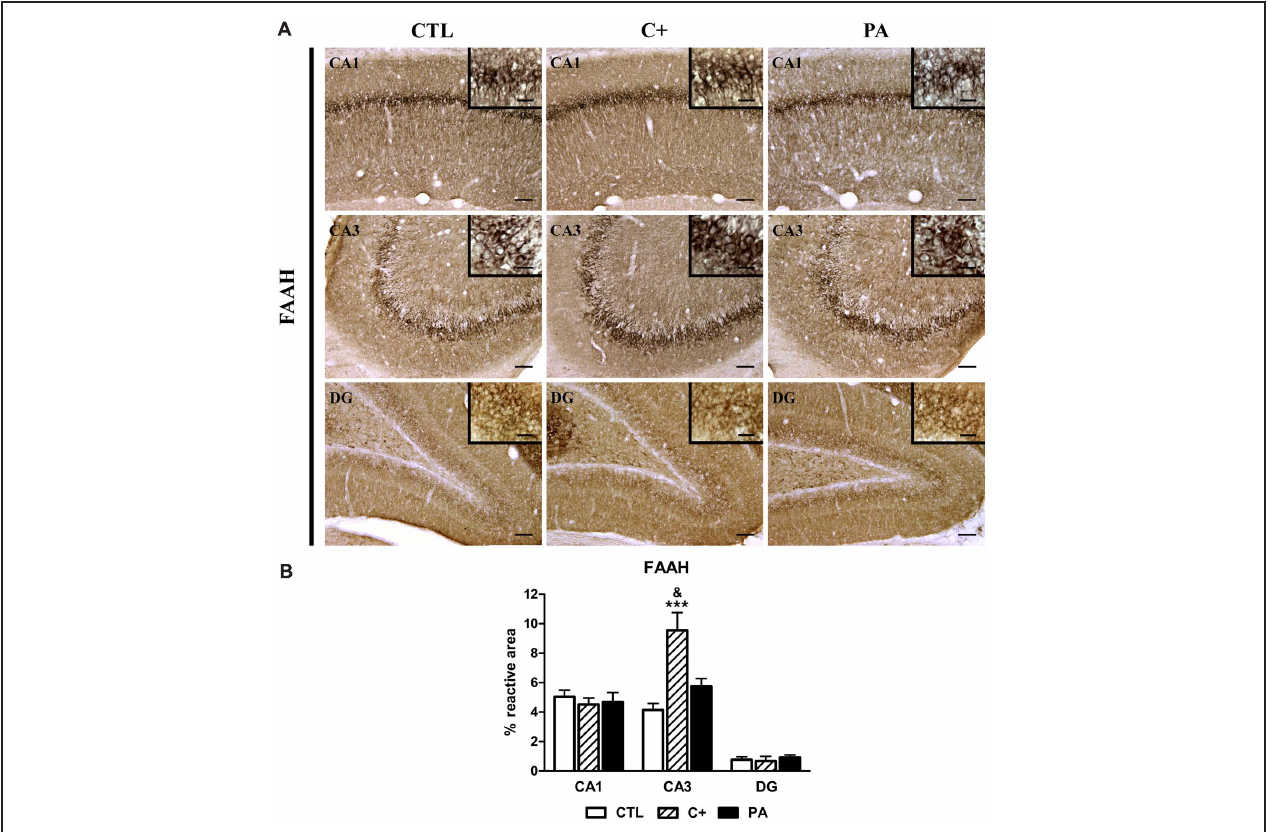
FIGURE 6 | Immunohistochemical expression of FAAH in dorsal hippocampus. (A) Representative photomicrographs showing positive immunostaining of FAAH in CA1, CA3, and DG regions of the dorsal hippocampus in the different groups (CTL, C + , and PA). Scale bars = 15 and 3 μ m in insets. (B) Quantification of FAAH, as the percentage of stained area over the total area of the region of interest, in CA1, CA3, and DG regions of the dorsal hippocampus in the different experimental groups. Bars and error bars show the mean + SEM of 5–7 observations per rat of a total of six animals per group. ∗∗∗ p < 0.001 vs. CTL; & p < 0.05 vs. PA. CTL, control group; C + , cesarean section group; PA, perinatal asphyxia group; CA1, cornu ammonis 1; CA3, cornu ammonis 3; DG, dentate